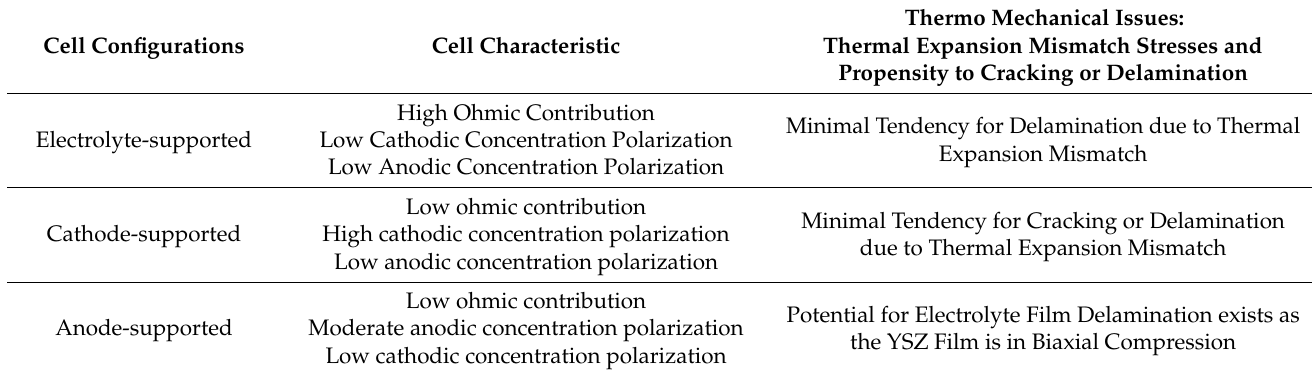
Figure 3. SEM micrograph of a single cell (electrolyte: YSZ in center, cathode: porous LSM, anode: porous NiO-YSZ): ( a ) electrolyte-supported, ( b ) cathode-supported, ( c ) anode-supported. Table 1. A summary of the characteristics of different self-supported SOFCs.